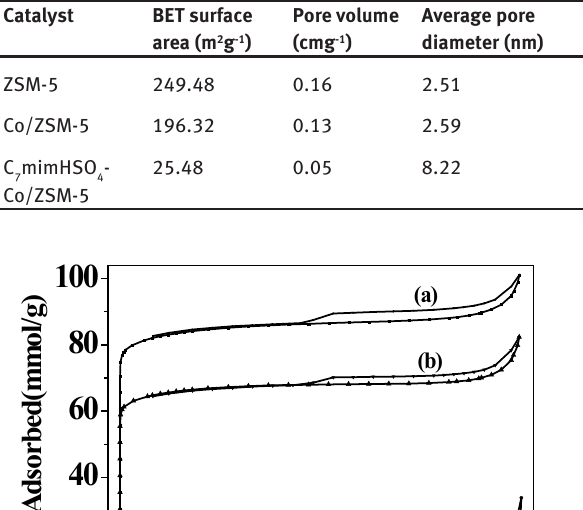
Table 1: BET surface area and pore characters of catalysts. Catalyst